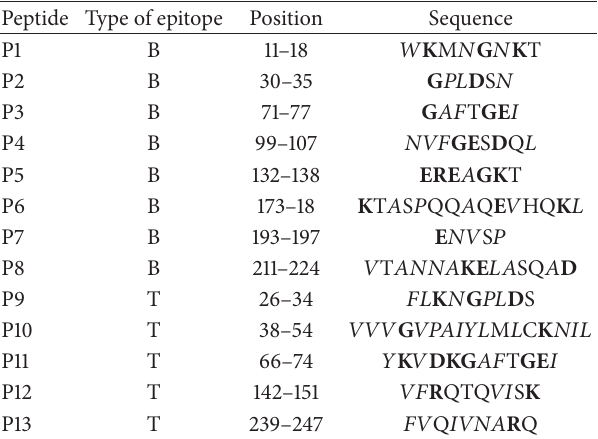
Table 2: Predicted B and T cell epitopes of Der f 25 allergen. Peptide Type of